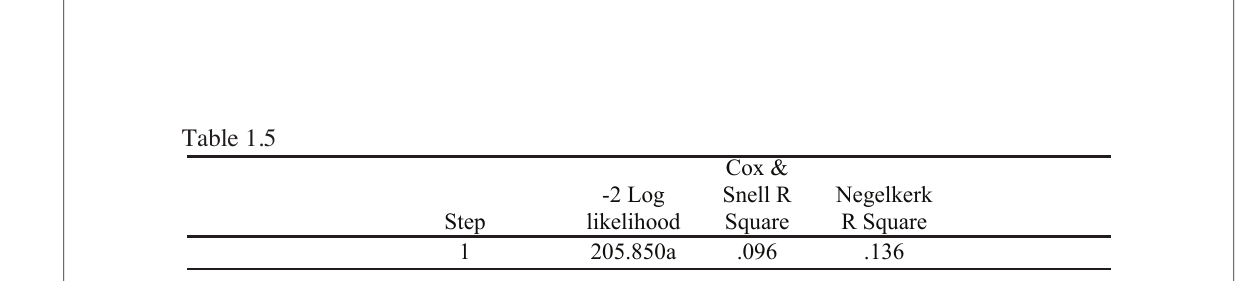
-2 Log likelihood